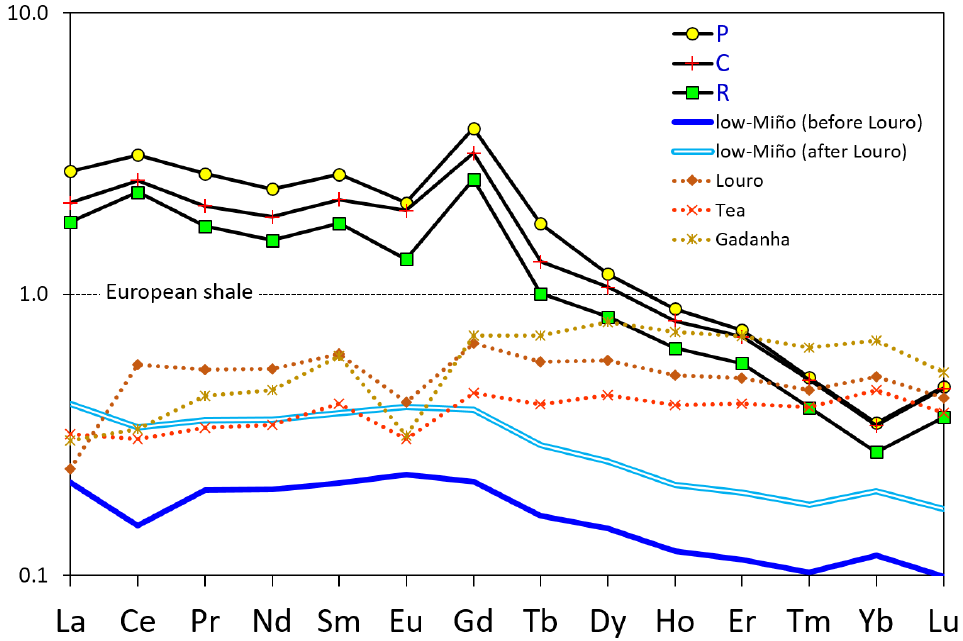
Figure 3. European shale [28] normalized patterns (logarithmic scale) of Ln-REE in sediments of the sampled section of the Miño River according to its origin (P: surface sediments trapped into rock cavities; C: sediment depth core trapped into a pothole; R: untrapped surface river sediments). Data from the lower course of Miño River [34] was provided for comparison (main channel before and after the Louro River, a known source of REE, and three tributaries of the low Miño, i.e., Tea, Louro, and Gadanha Rivers).